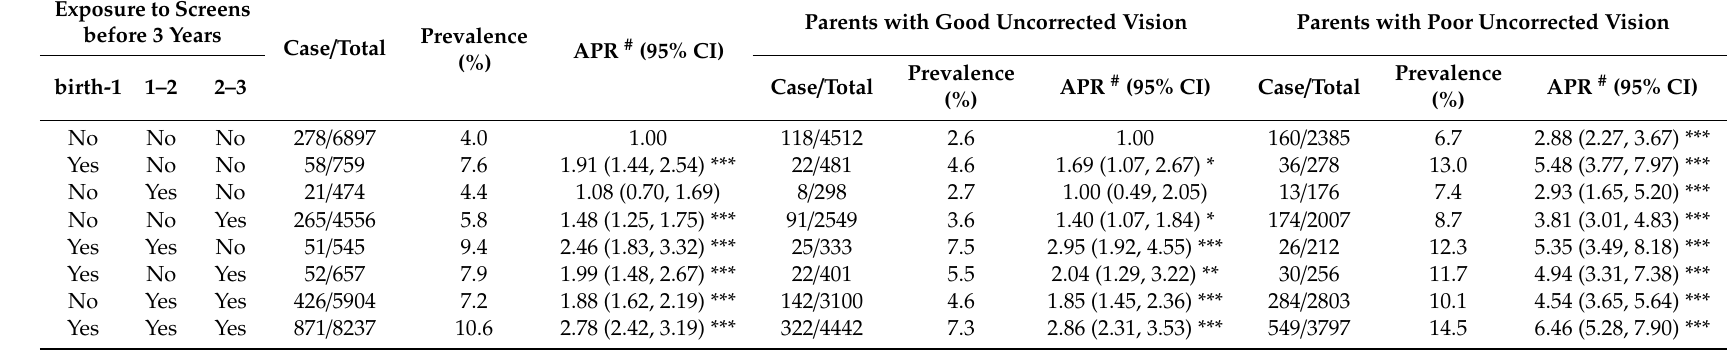
Table 4. Associations between exposure to screens during early life (postnatal three years) and astigmatism. Exposure to